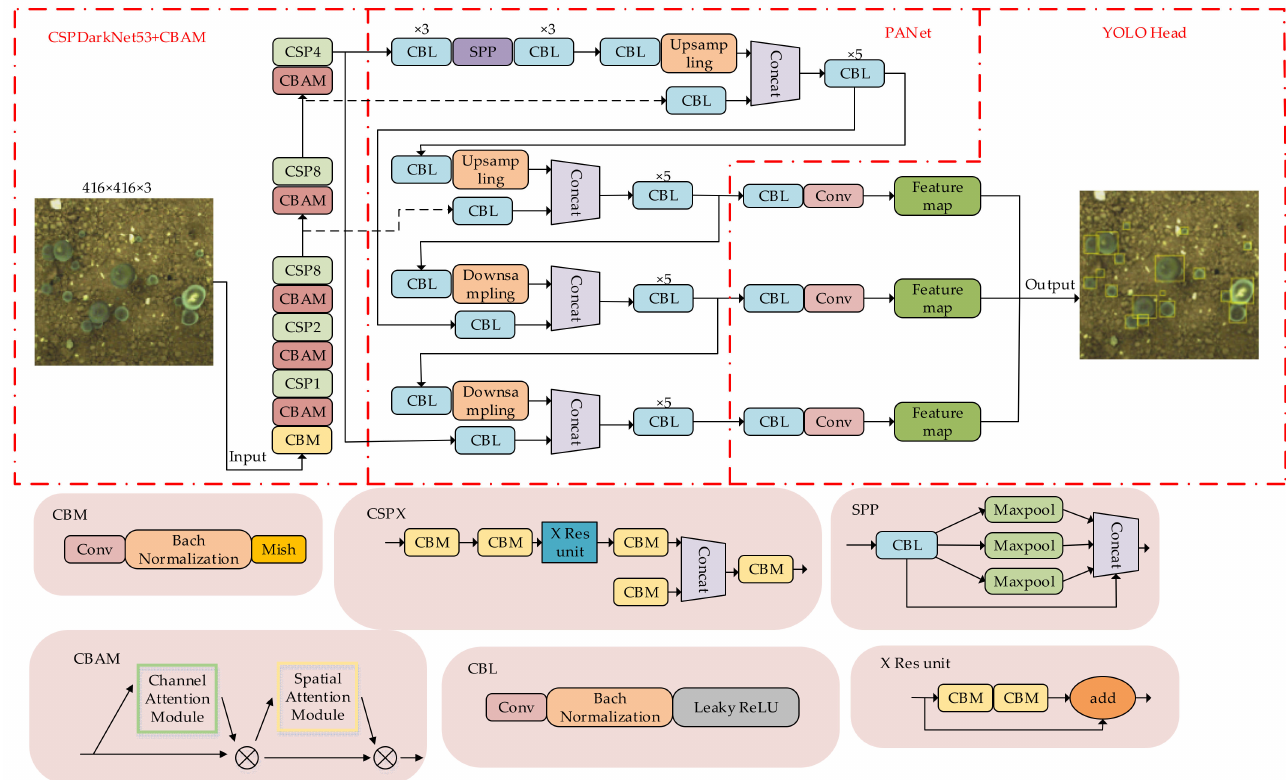
Figure 3. Structure illustration of the improved YOLO v4.